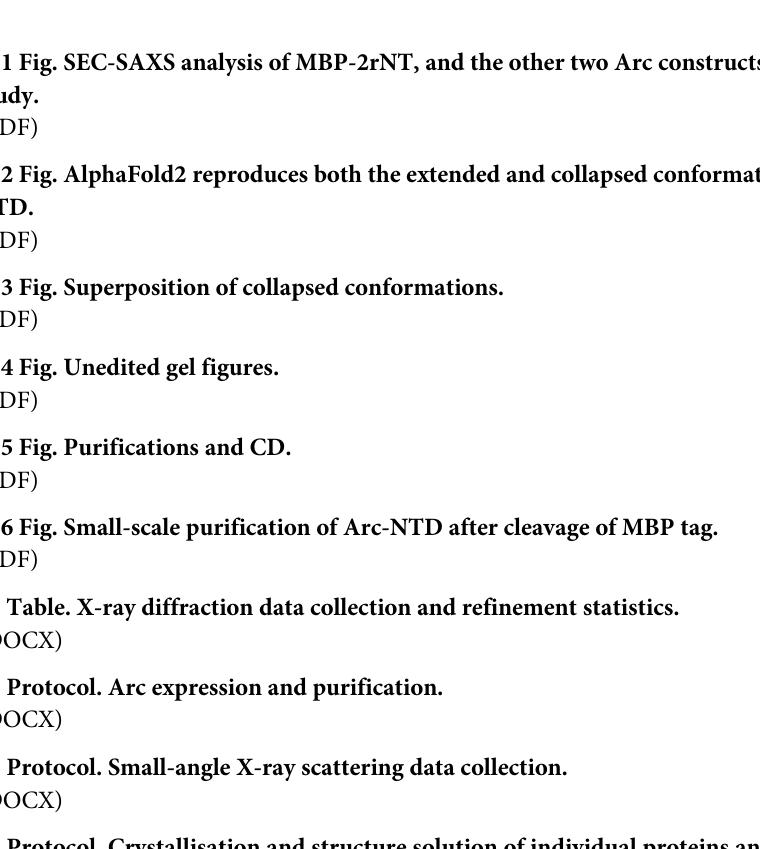
S1 Table. X-ray diffraction data collection and refinement